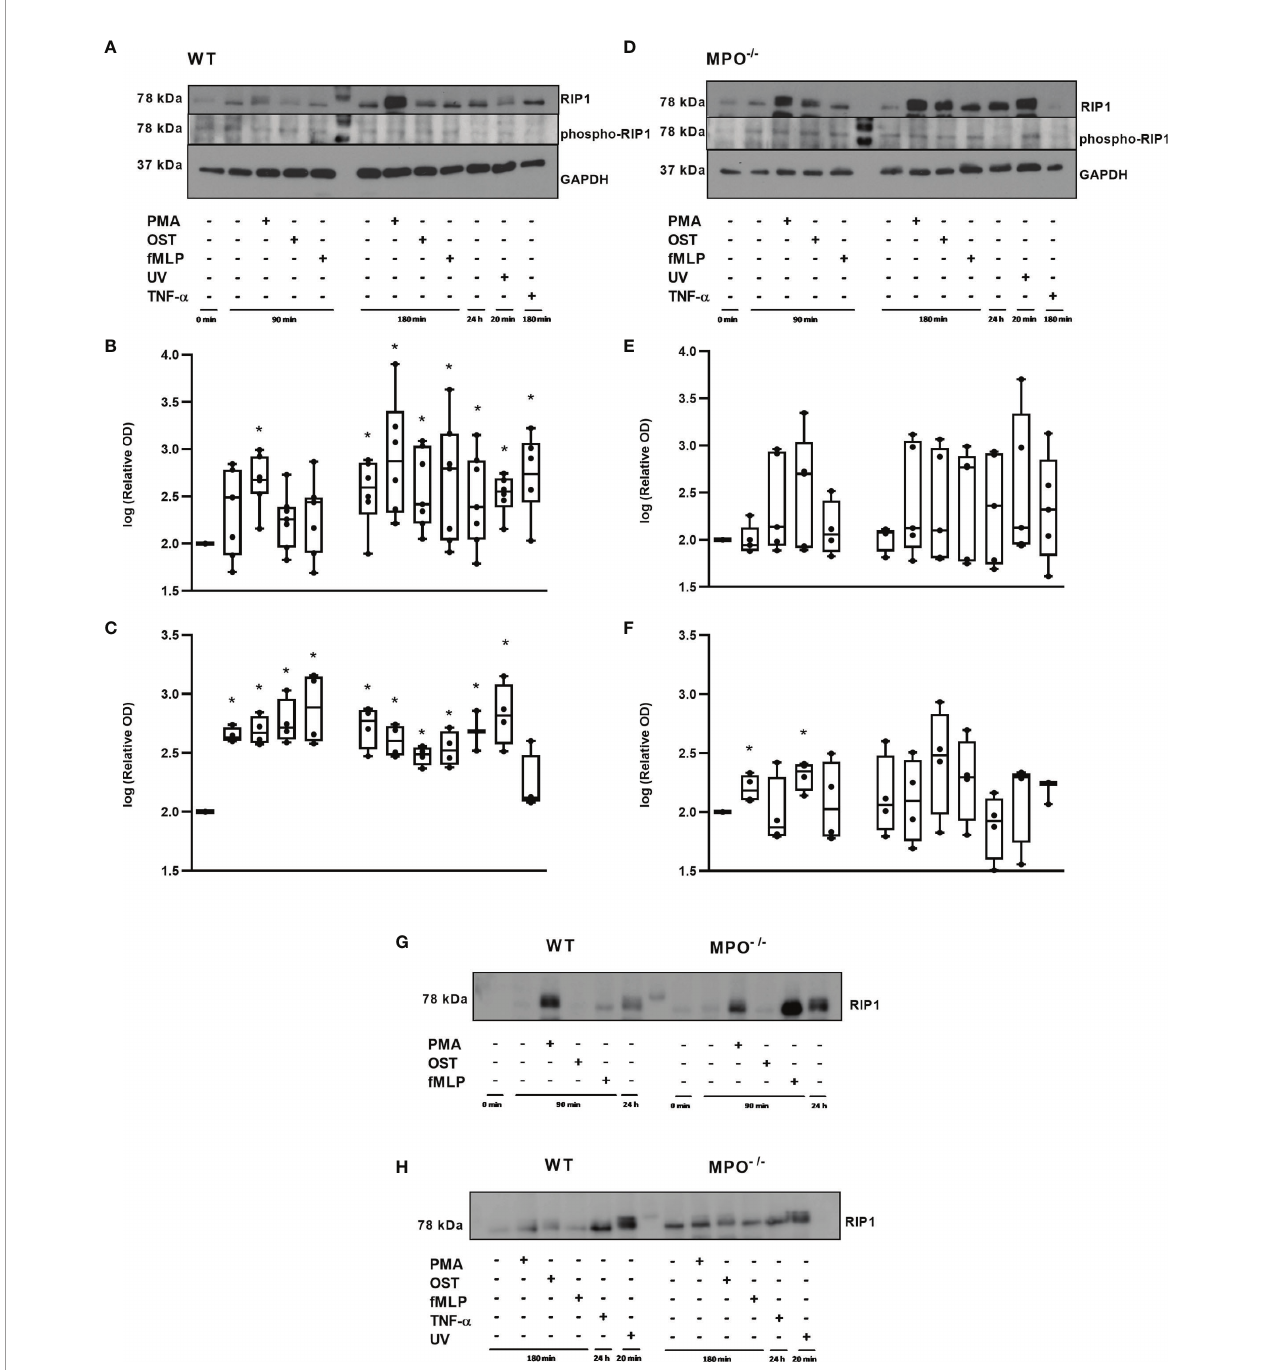
FIGURE 5 | Expression of total and phosphorylated RIP1 in PMNs from WT (A – C, G, H) and MPO -/- (D – F, G, H) mice after the induction of oxidative burst by PMA, OST, and fMLP for 90 min and 180 min. PMNs (1x 10 7 cells/ml) isolated from BALF of WT and MPO -/- mice were stimulated with PMA (80 nM), OST (1:10 MOI) and fMLP (1.14 m M) for 90 and 180 min. PMNs incubated for 24 h without stimulation, PMNs irradiated by UV for 20 min, and PMNs treated by TNF- a (10 ng/ml) for 180 min were tested as positive controls. Total and phosphorylated protein RIP1 and GAPDH (as a marker of equal loading) were determined by Western blot. Analysis of OD was performed using ImageJ, and values are depicted as percentage of untreated control transformed by Log2 to normalize the data distributions (B, C, E, F) . Data are presented as median, 25, and 75 percentiles (the box) and 10 and 90 percentiles (the whiskers), and individual values are drawn as individual dots, n = 3-5. *Shows statistically signi fi cant difference (p < 0.05) compared with untreated control (Ctrl). Figures (A, D, G, H) represent typical